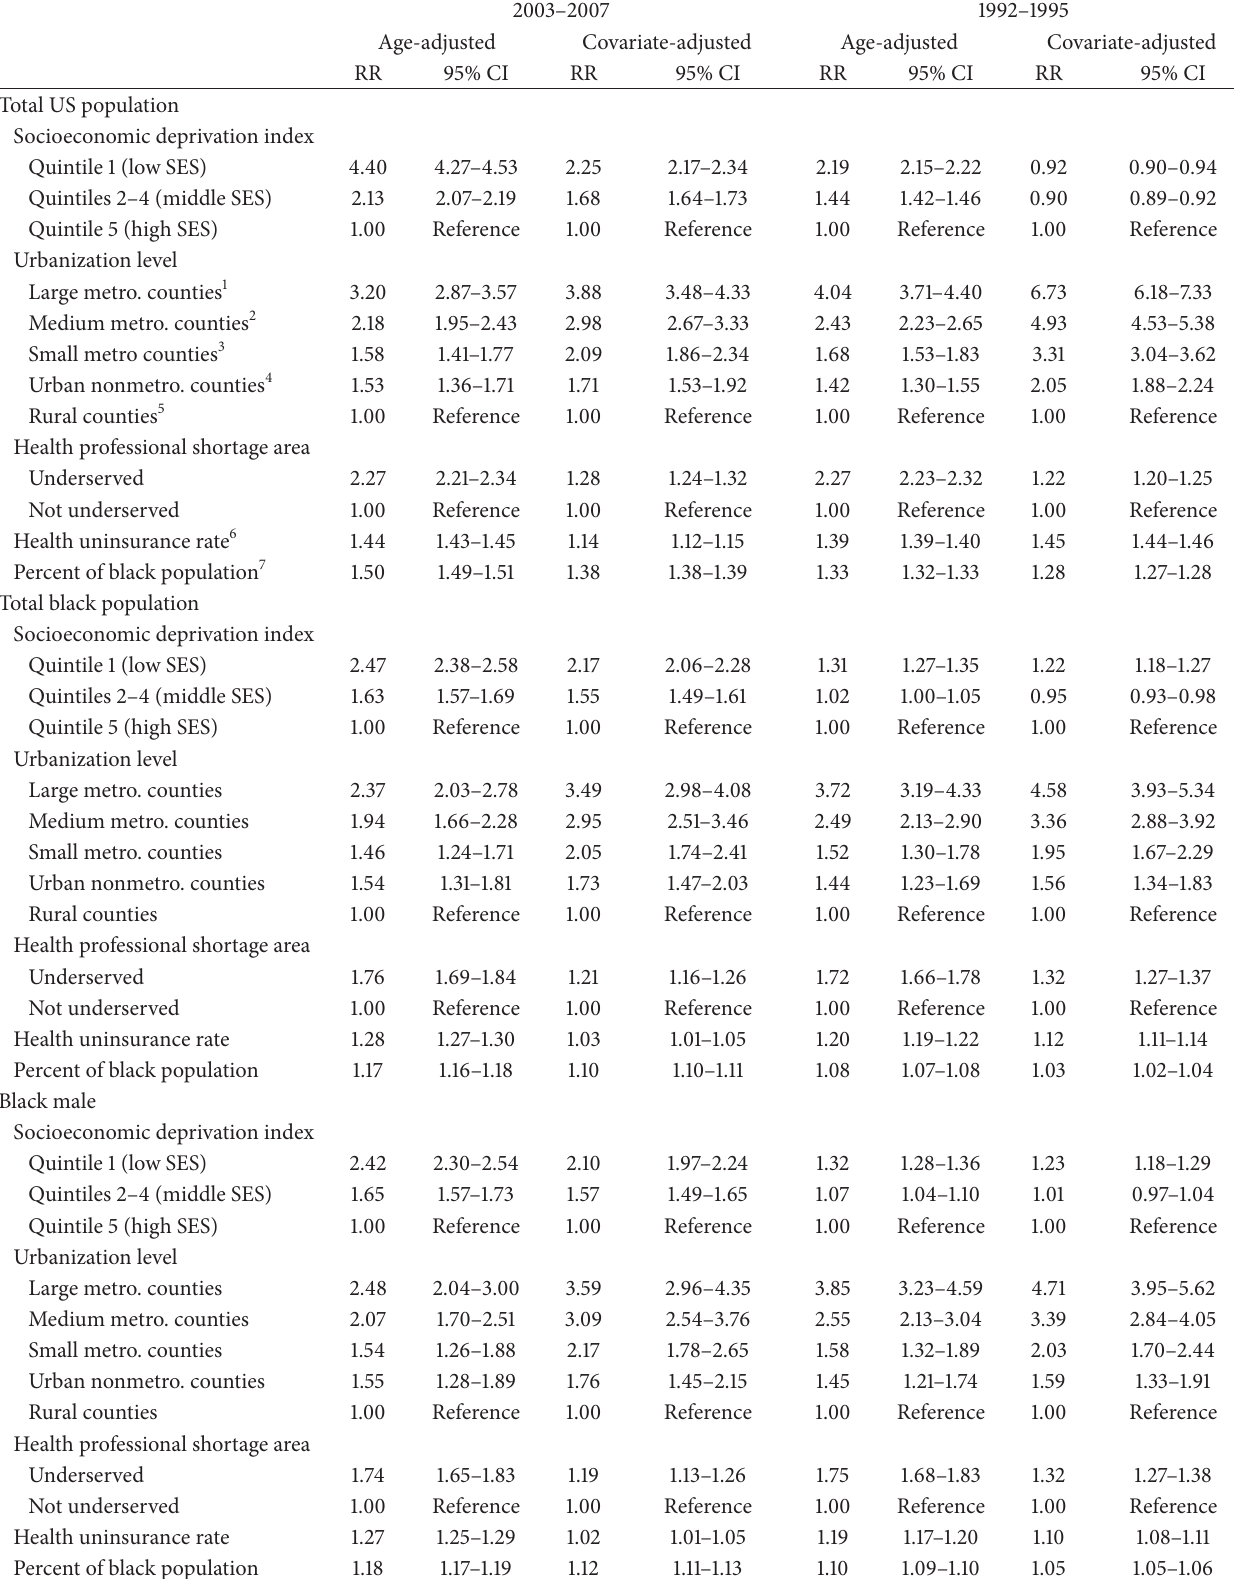
Table 3: Poisson regression models showing relative risk (RR) of HIV/AIDS mortality according to socioeconomic deprivation,